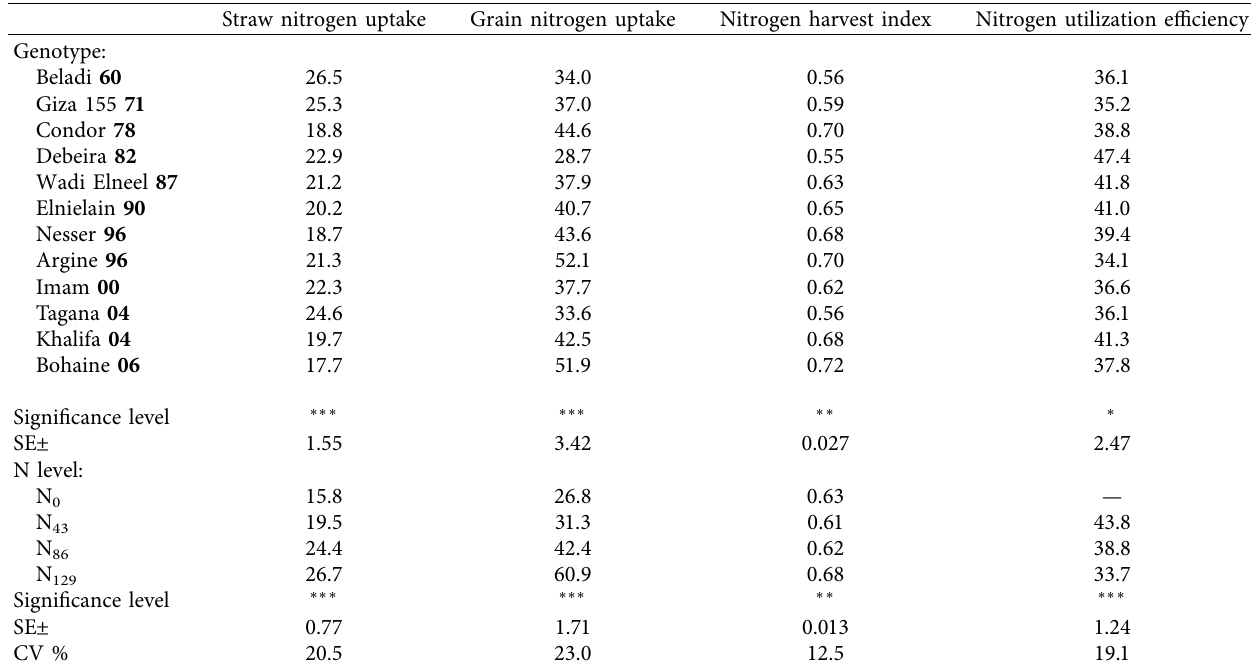
Table 5: Straw and grain nitrogen uptake (kg/ha), nitrogen harvest index (NHI), and nitrogen utilization efficiency (NUTE) of 12 bread